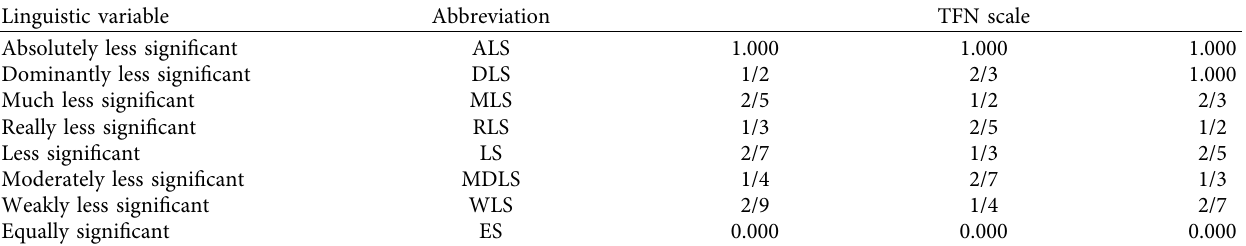
Table 1: Linguistics and the TFN scale for the evaluation of the criteria in the improved IMF SWARA method.